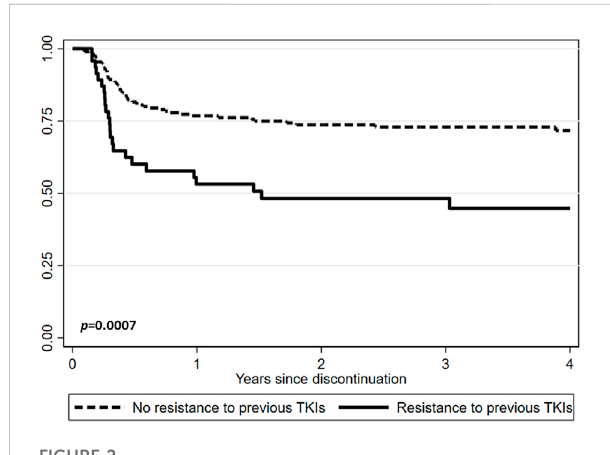
FIGURE 2 Treatment-free remission (TFR) after tyrosine kinase inhibitor (TKI) therapy (Kaplan-Meier survivor function) according to resistance to previous